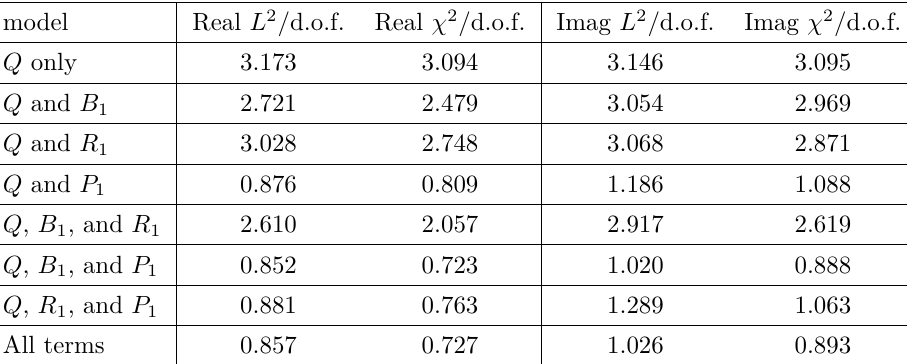
Table 2 . The L 2 /d.o.f. and χ 2 / d.o.f. of models using 2 Jacobi polynomials for the PDF and